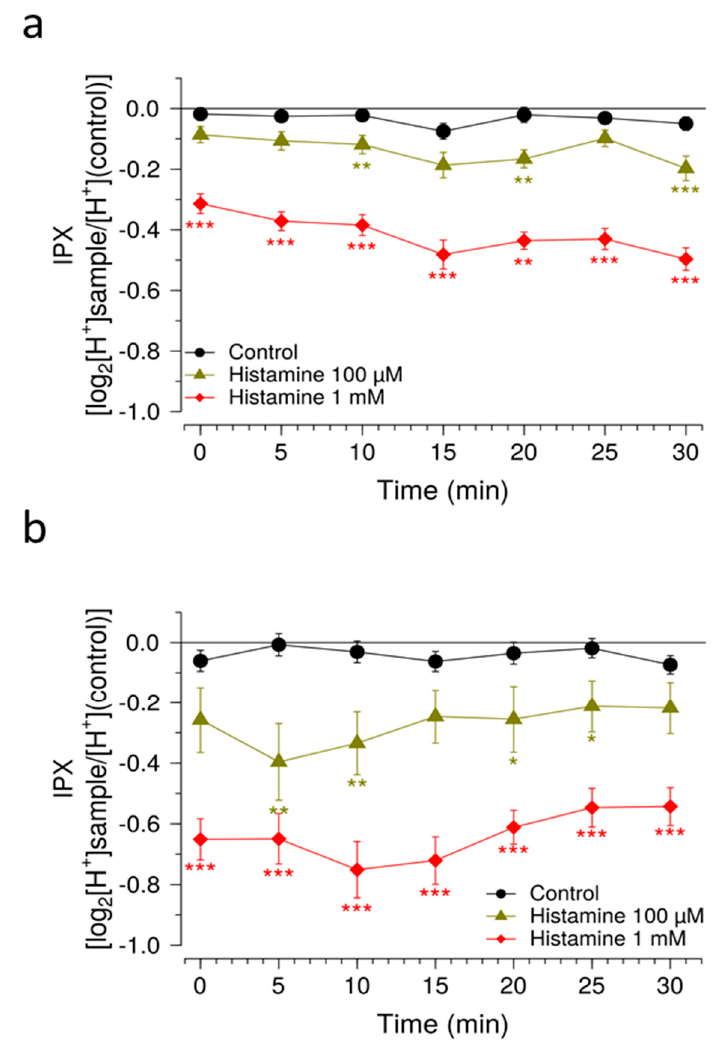
Figure 4. Histamine priming of HGT-1 cells. Intracellular proton index (IPX) of HGT-1 cells ex- posed to 100 and 1000 µ M histamine (green diamonds and red squares, respectively) without ( a ) and with ( b ) 10 µ M histamine pretreatment. Recordings were performed at room temperature at intervals of 5 min. Evaluated wells contained 20 µ M EIPA and 20 µ M DIDS for inhibiting HCO 3 − extrusion systems. Cells treated with vehicle solution served as negative control (circles). Data presented as mean ± SEM. Statistical significance was evaluated using one-way ANOVA with Tukey’s range test for multiple comparisons. N of 4 BR, 8–12 TR. * denotes p < 0.05, ** denotes p < 0.01 and *** denotes p < 0.001 for the corresponding histamine concentration when compared to negative